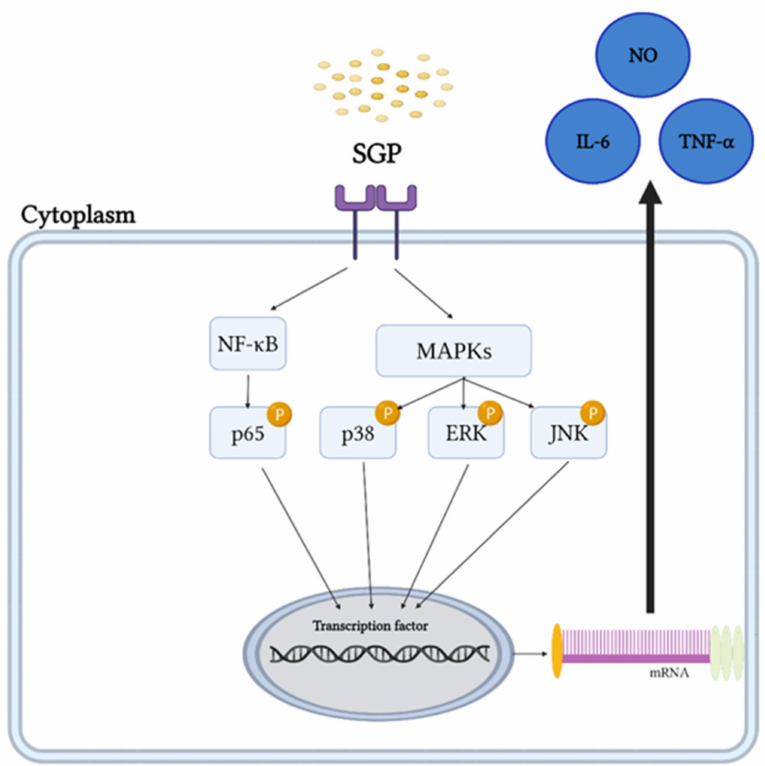
Figure 7. Schematic diagram of MAPKs and NF- κ B signaling pathways on SGP treatment in RAW264.7